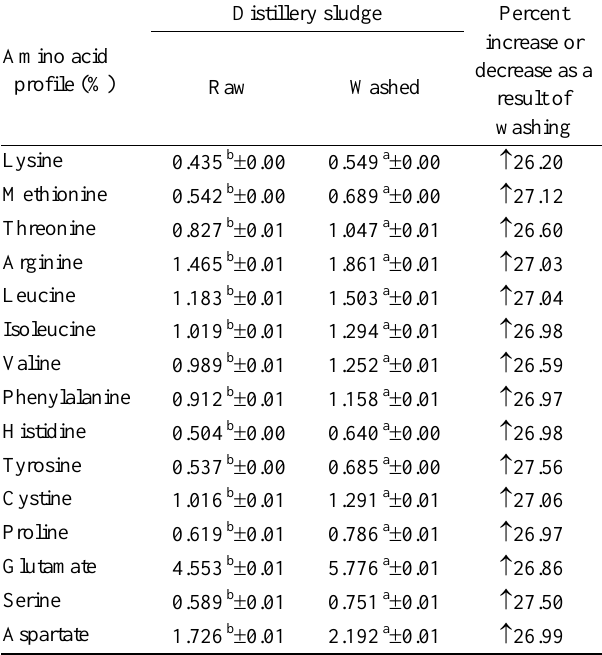
Means in a row with different superscripts differ significantly (p<0.01).